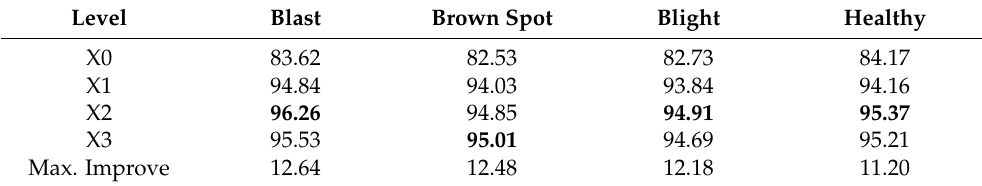
Table 8. The effect of the strength of data enhancement on the accuracy of the GoogLeNet model (%).